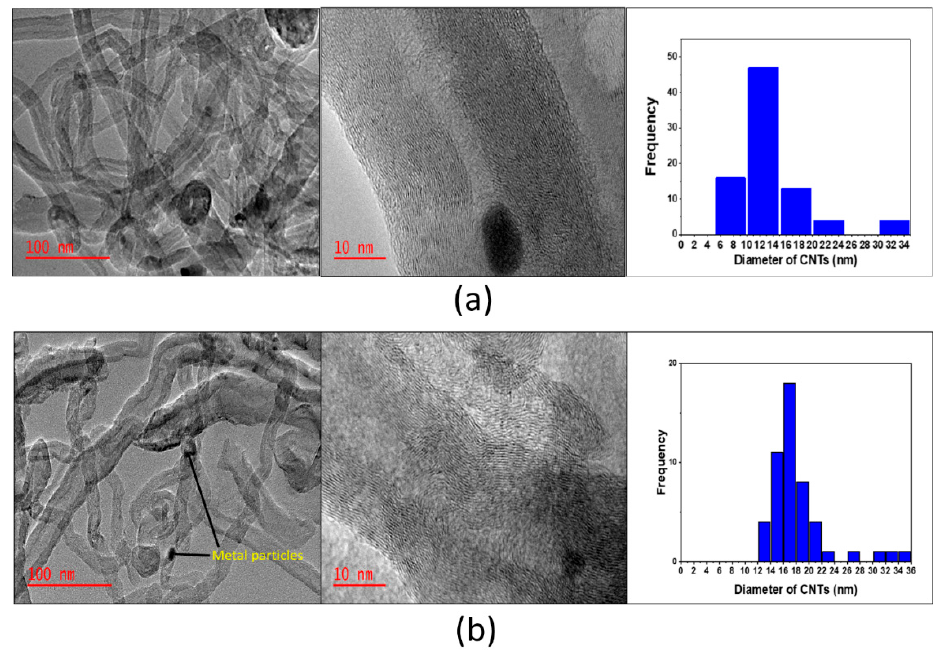
Figure 6. TEM images and diameter distribution histograms of as-grown carbon nanotubes (CNTs) over NiMo / CaTiO 3 catalysts containing di ff erent support content: ( a ) NMC412, ( b )